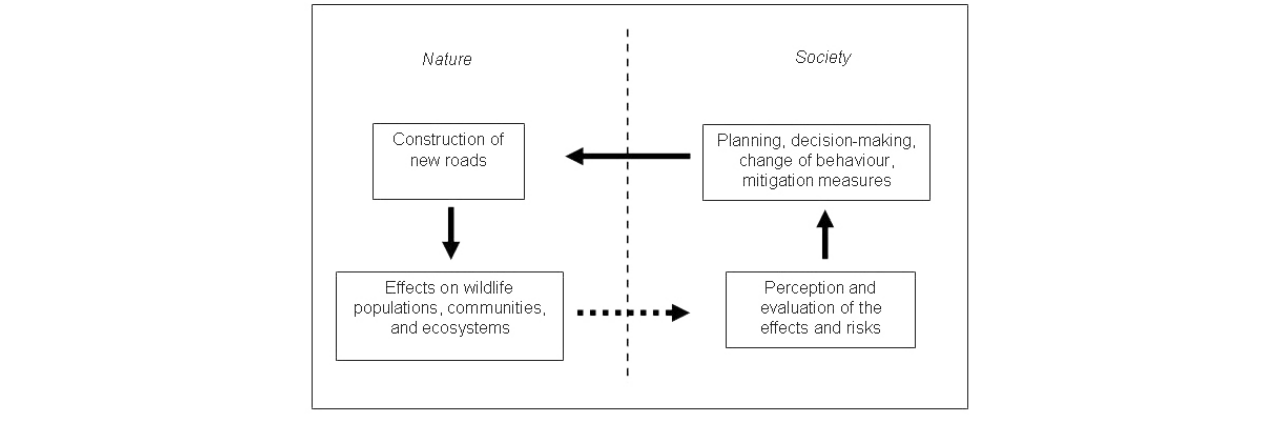
Fig. 1. Society’s ability to address the negative effects of road networks on wildlife populations and ecosystems depends on the perception of the ecological effects and risks. As the perception of the effects by society has been severely limited (as indicated by the dotted line), alternative approaches may be required that would be based on more indirect indicators of ecological risk and on the precautionary